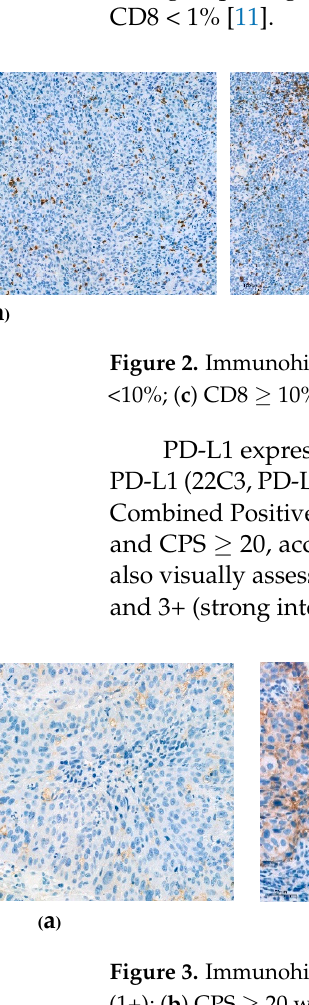
Figure 1 . Immunohistochemistry of p16 - positive OPSCC ( 100× ).